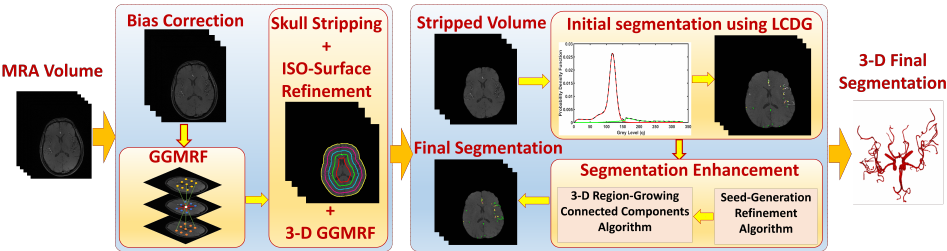
Figure 2. Module 1: MRA data preprocessing and